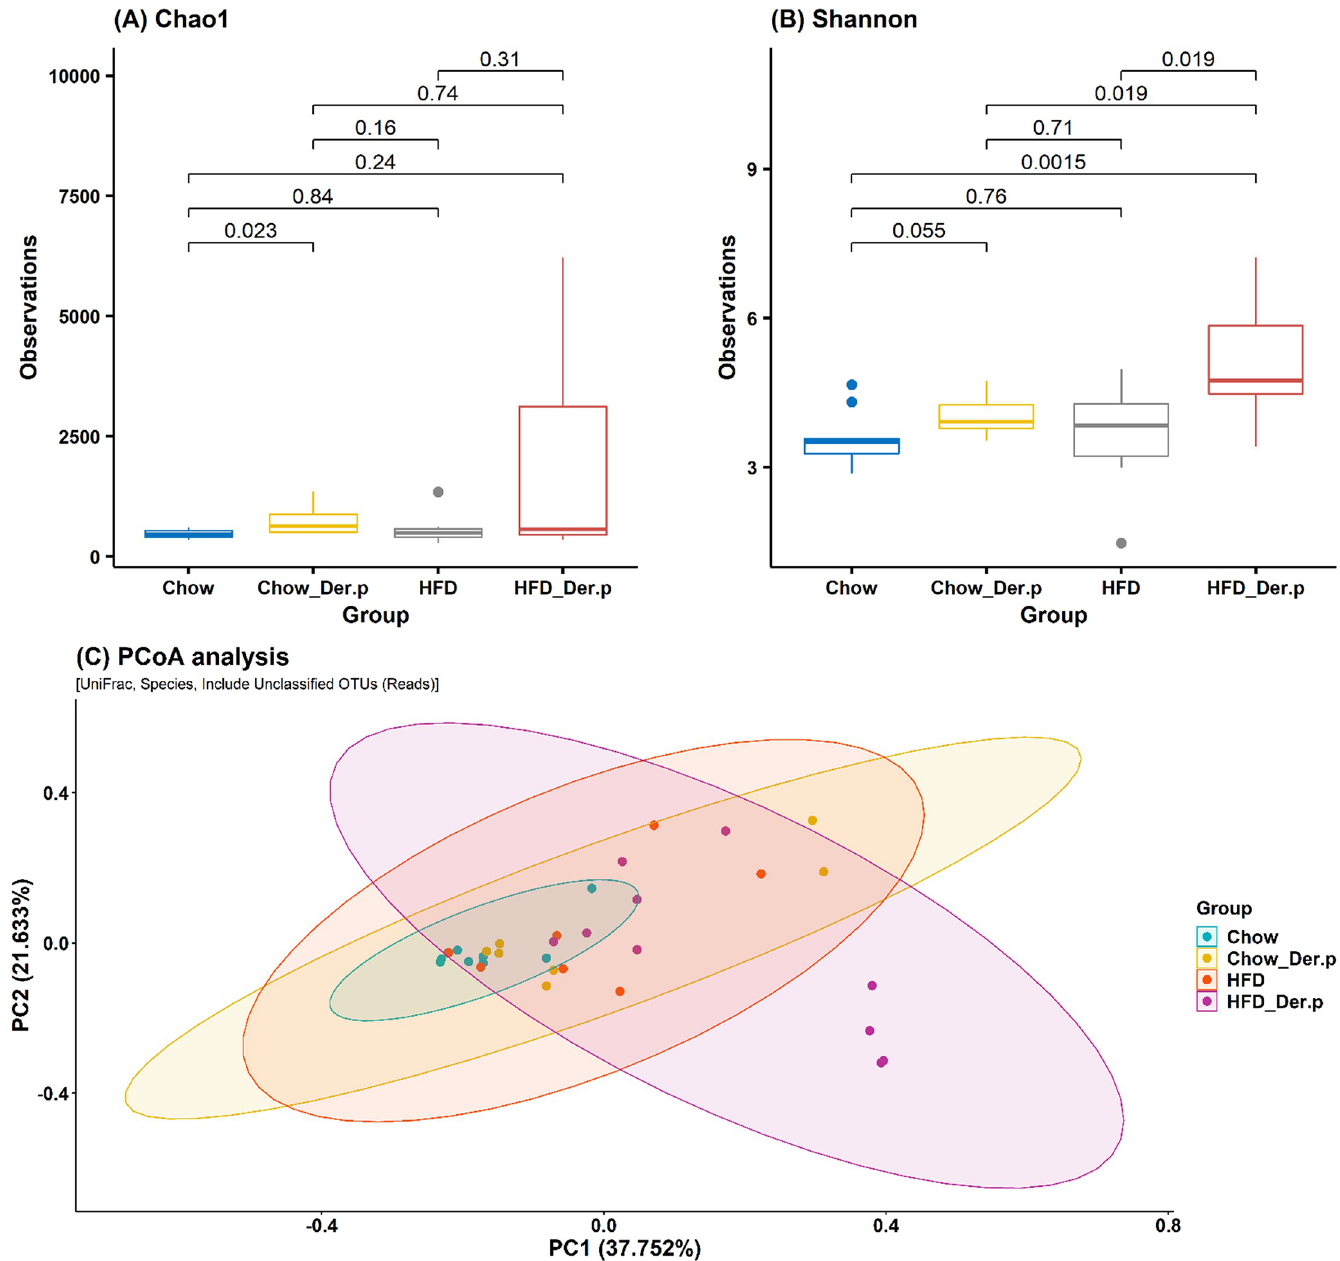
Fig 5. Alpha and beta diversity in lung microbiome in Chow (n = 9), Chow_Der.p (n = 7), HFD (n = 7), and HFD_Der.p groups (n = 10). The boxplot of (A) Chao1, (B) Shannon index was shown with p-values (Wilcoxon rank-sum test). The median (line within the box), lower quartiles (Q1), upper quartiles (Q3), non- outlier range (whiskers), and outliers (dot) was described in the boxplot. (C) The PCoA analysis was fulfilled at a species level with UniFrac distances, including unclassified